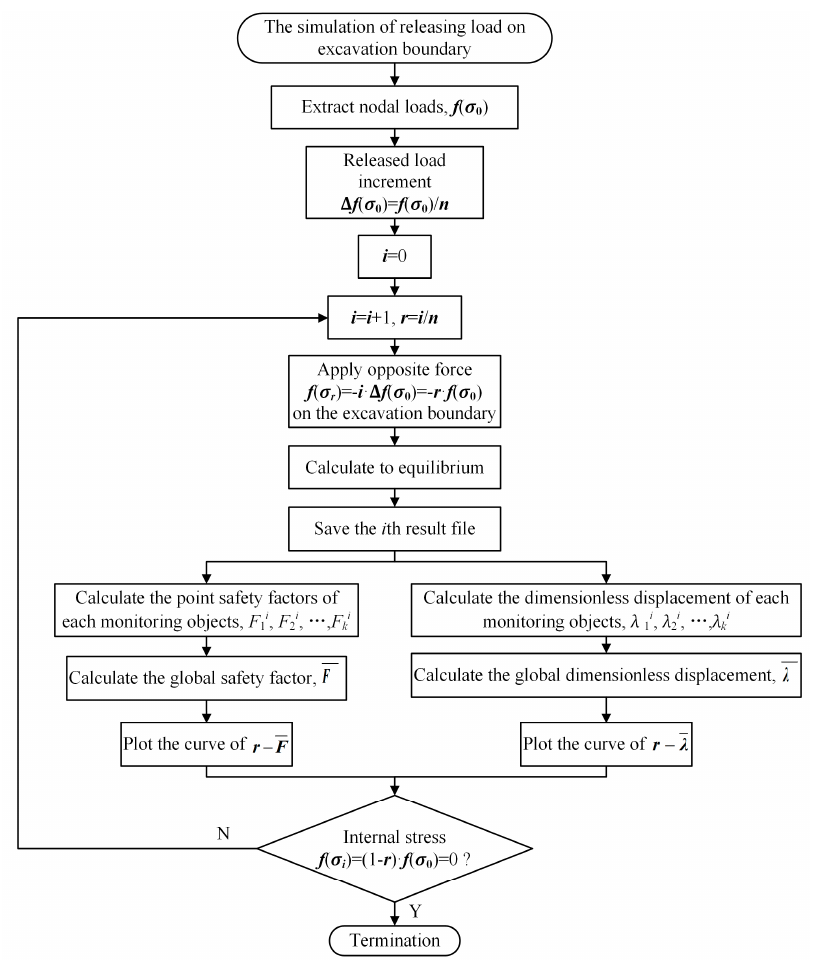
Figure 4. Process of releasing load on excavation boundary.